Question: Write a single sentence explaining what this figure depicts.
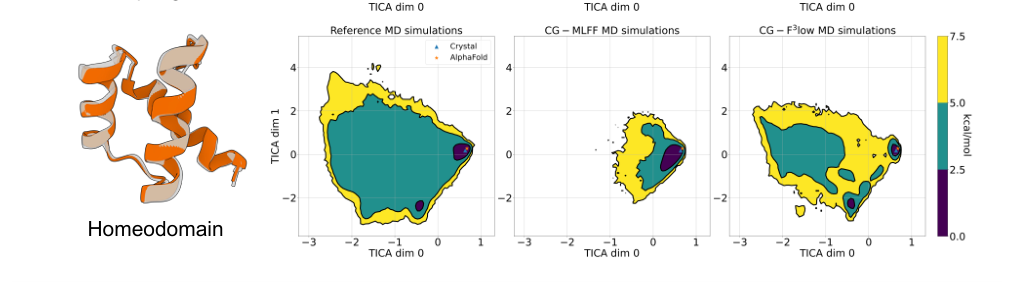
Answer: Comparison of free energy surface across reference, CG-MLFF and CG-F3low simulations. The crystal structure (gray) and the lowest RMSD structure in CG-F3low simuluation (colored) are presented on the left, respectively. The corresponding Min. RMSD can be found in Table 1.